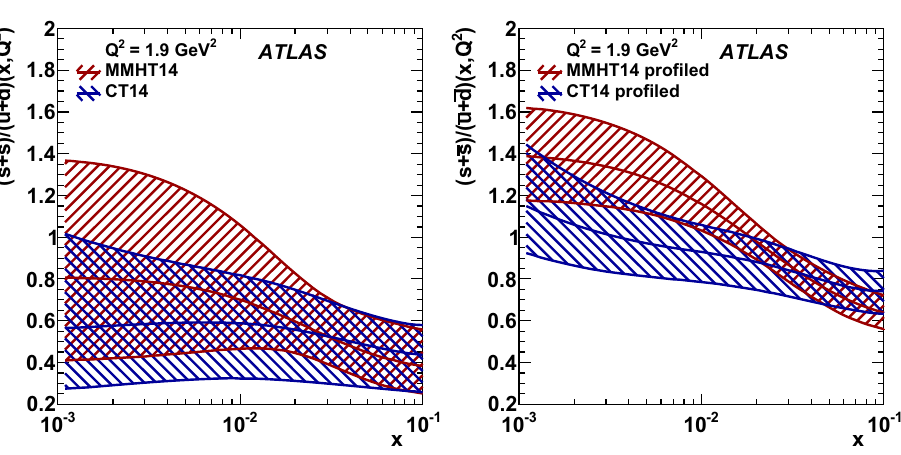
Fig. 25 Ratio R s ( x ) = ( s ( x ) + ¯ s ( x ))/( ¯ u ( x ) + ¯ d ( x )) as a function of Bjorken- x at a scale of Q 2 = 1 . 9 GeV 2 for the original MMHT14 and CT14 PDF sets ( left ) and for the MMHT14 and CT14 sets when profiled with the new W , Z differential cross-section data ( right